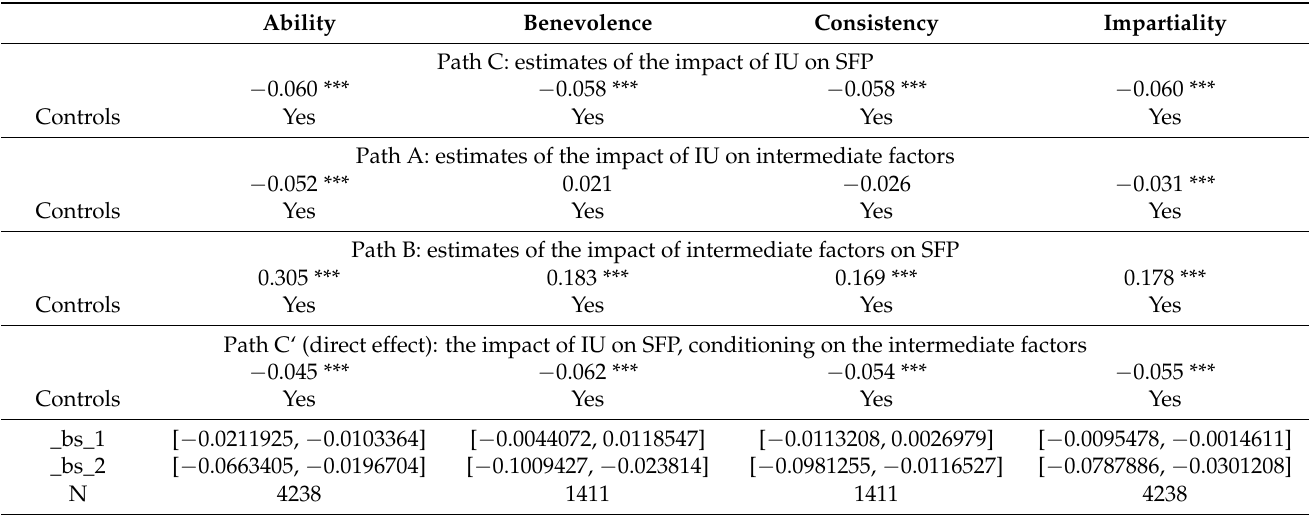
Table 7. Mechanism